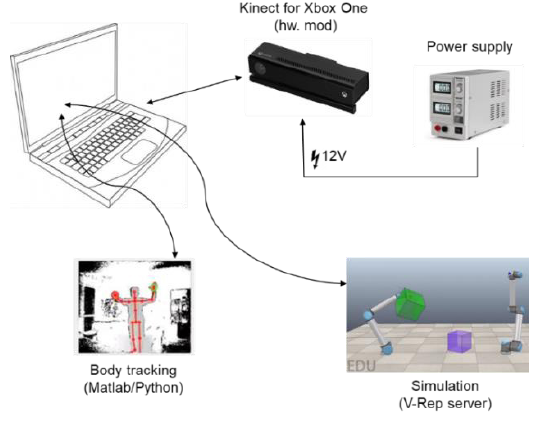
Fig. 5. Overview of system